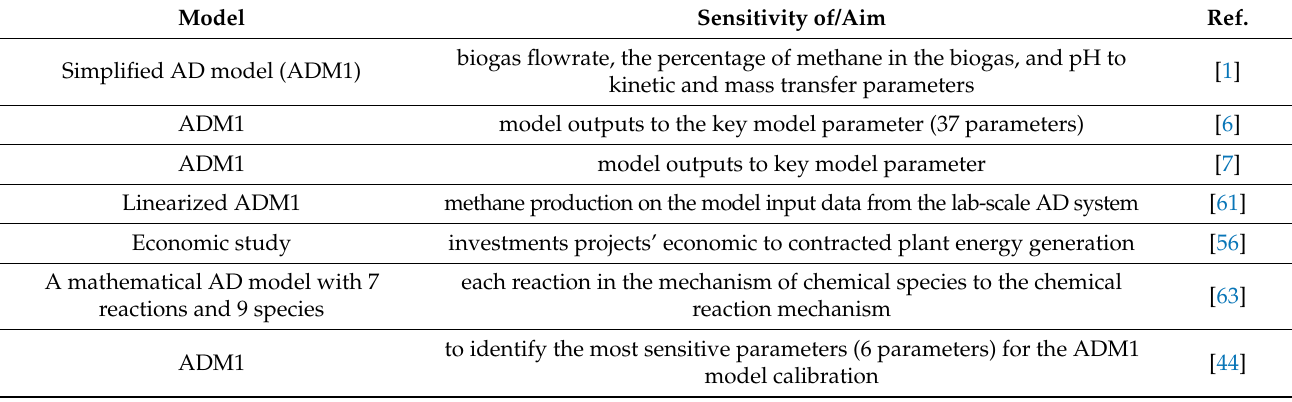
Table 4. Sensitivity approaches and methods used in